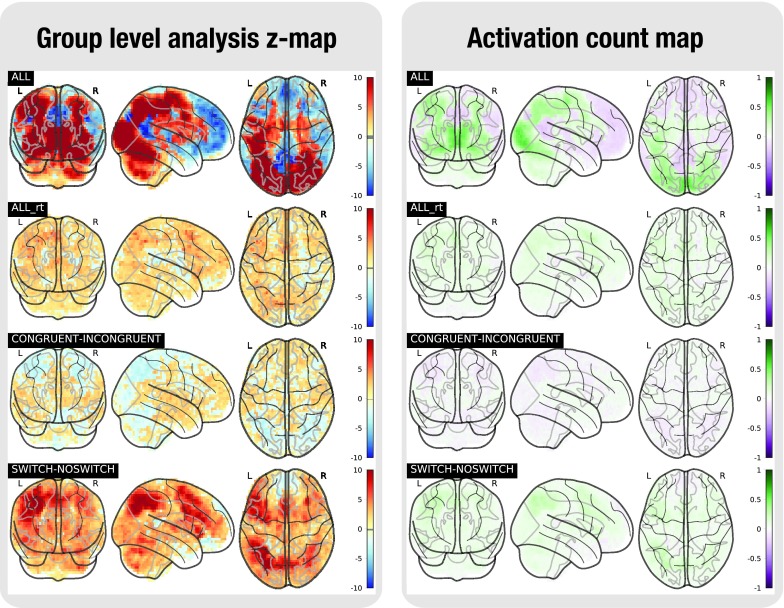
Task analysis results for the TASKSWITCH task.In the left plot, the statistical map of the one-sample group test, computed with randomise. The right plot shows the difference between the positive and the negative activation count maps.